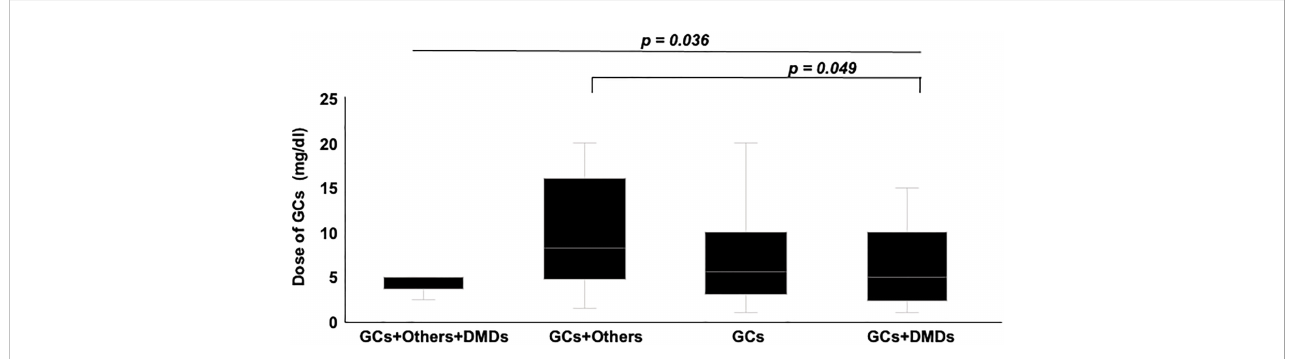
FIGURE 3 Comparison of GCs dose between groups divided according to treatment subtypes. Groups using Others and GCs showed the highest dose of GCs among groups. Post hoc analysis also showed signi fi cantly higher dose in groups using others and GCs, compared to group using